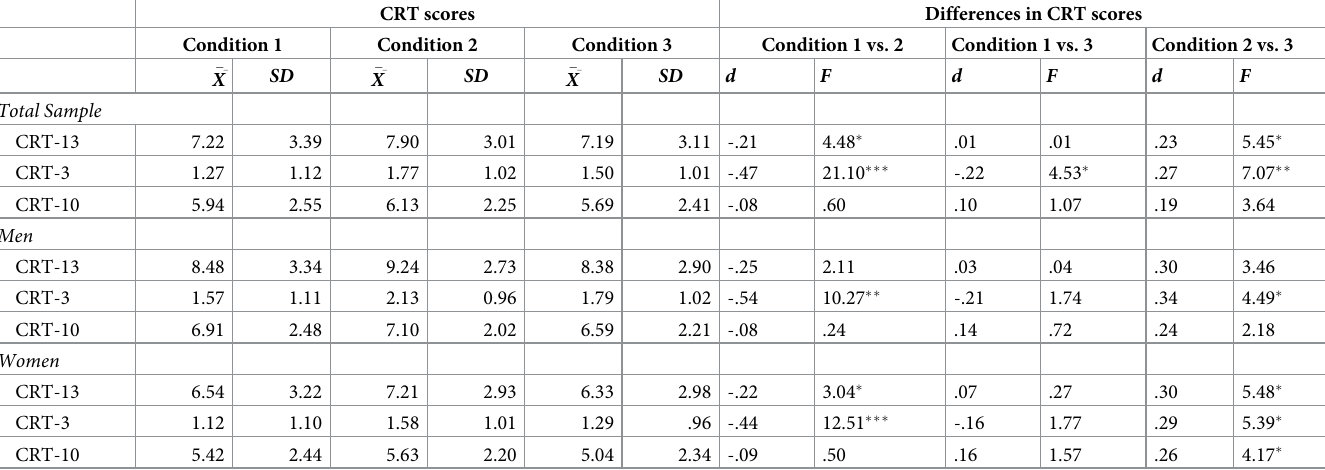
Table 2. Mean, standard deviations, and differences in CRT scores according to experimental